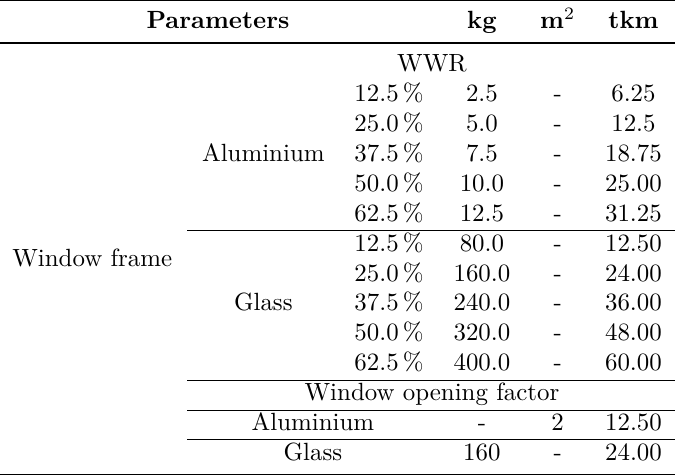
Table 3. Window parameters and materials used in the life cycle